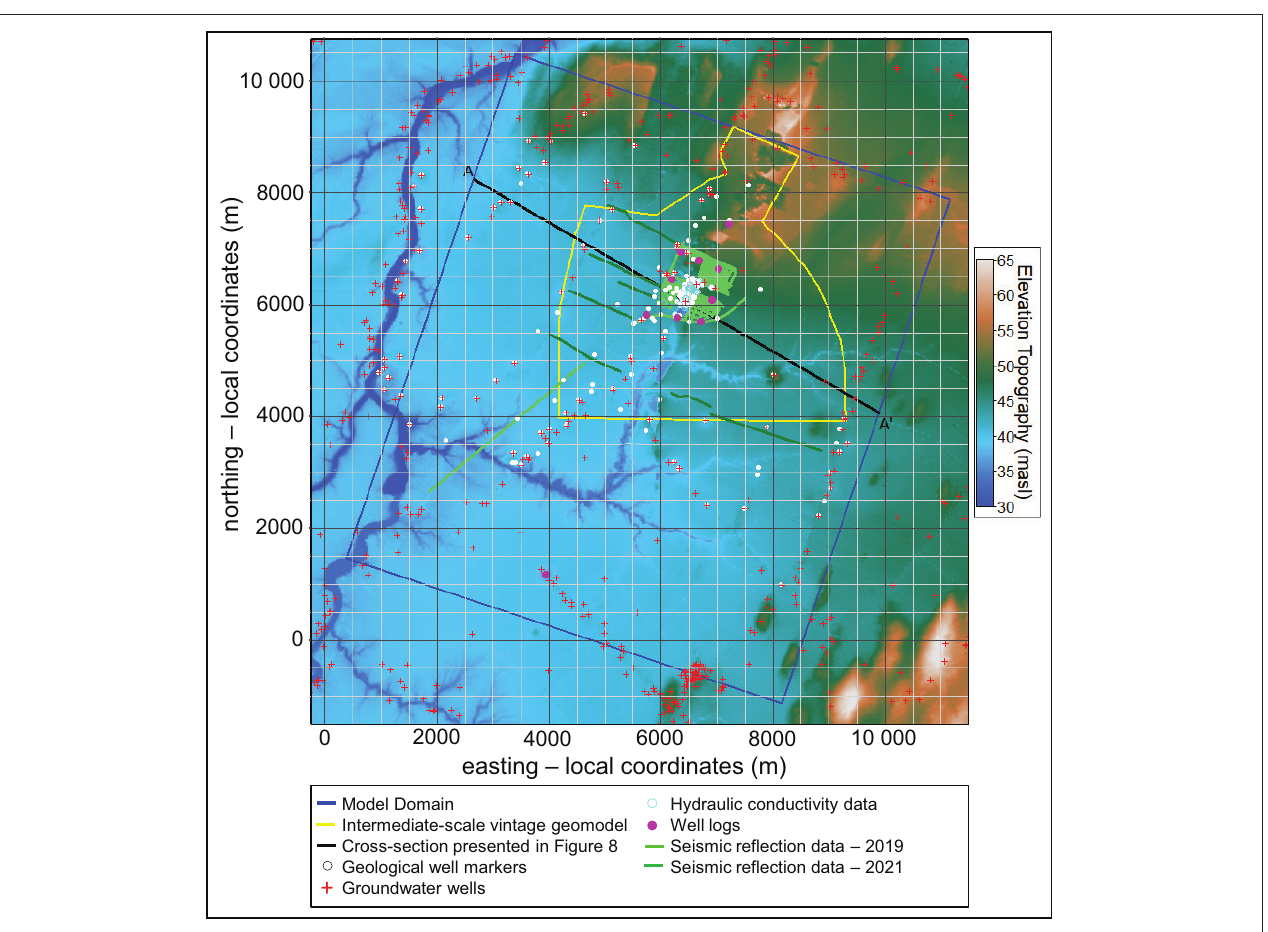
FIGURE 1 | Map of surface topography and available data in the model